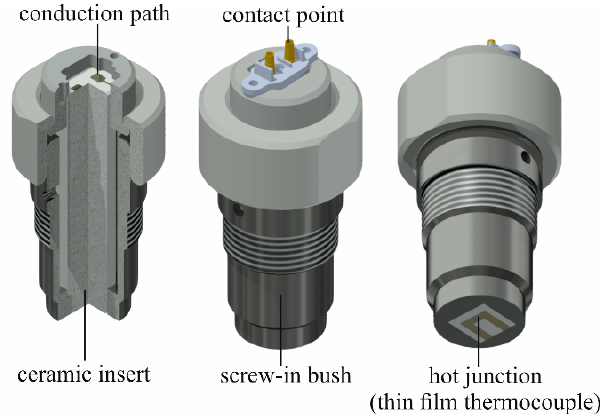
Figure 10. Structure of the exchangeable thin film thermocouple.